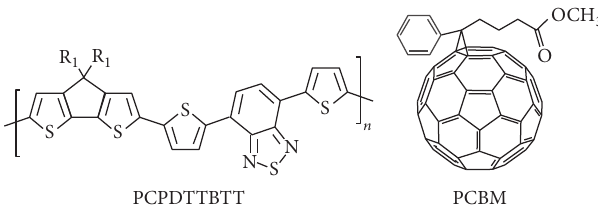
Figure 1: Chemical structure of PCPDTTBTT and PC 61